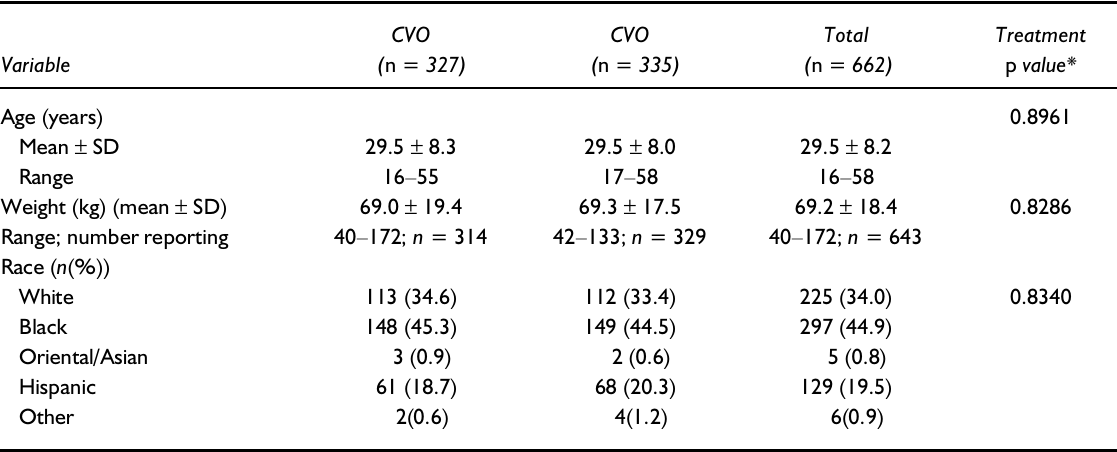
Figure 1 Algorithm of patient selection. BV, bacterial Table 1 Patient demographics (intent to treat (ITT) patients)